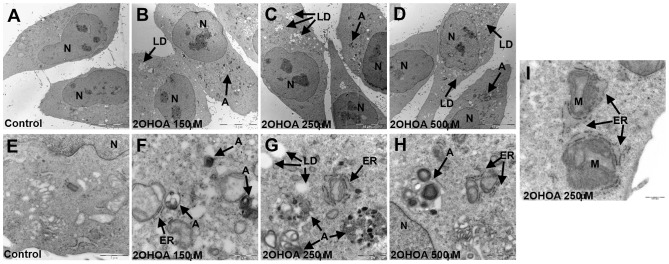
Electron microscopy of 1321N1 cells treated with 2OHOA: induction of Autophagosomes.Electron microscopy of 1321N1 cells maintained for 48 h in the absence (control: 10A and 10E) or presence of 2OHOA (150 µM: 10B and 10F; 250 µM: 10C, 10G and 10I; 500 µM: 10D and 10H). N: Nuclei; A: Autophagosomes; LP: Lipid Droplets; ER: Rough Endoplasmatic Reticulum; M: Mitochondria. Scale bar = 10 µm (10A–10D); 1 µm (10E–10H) and 500 nm (10I).